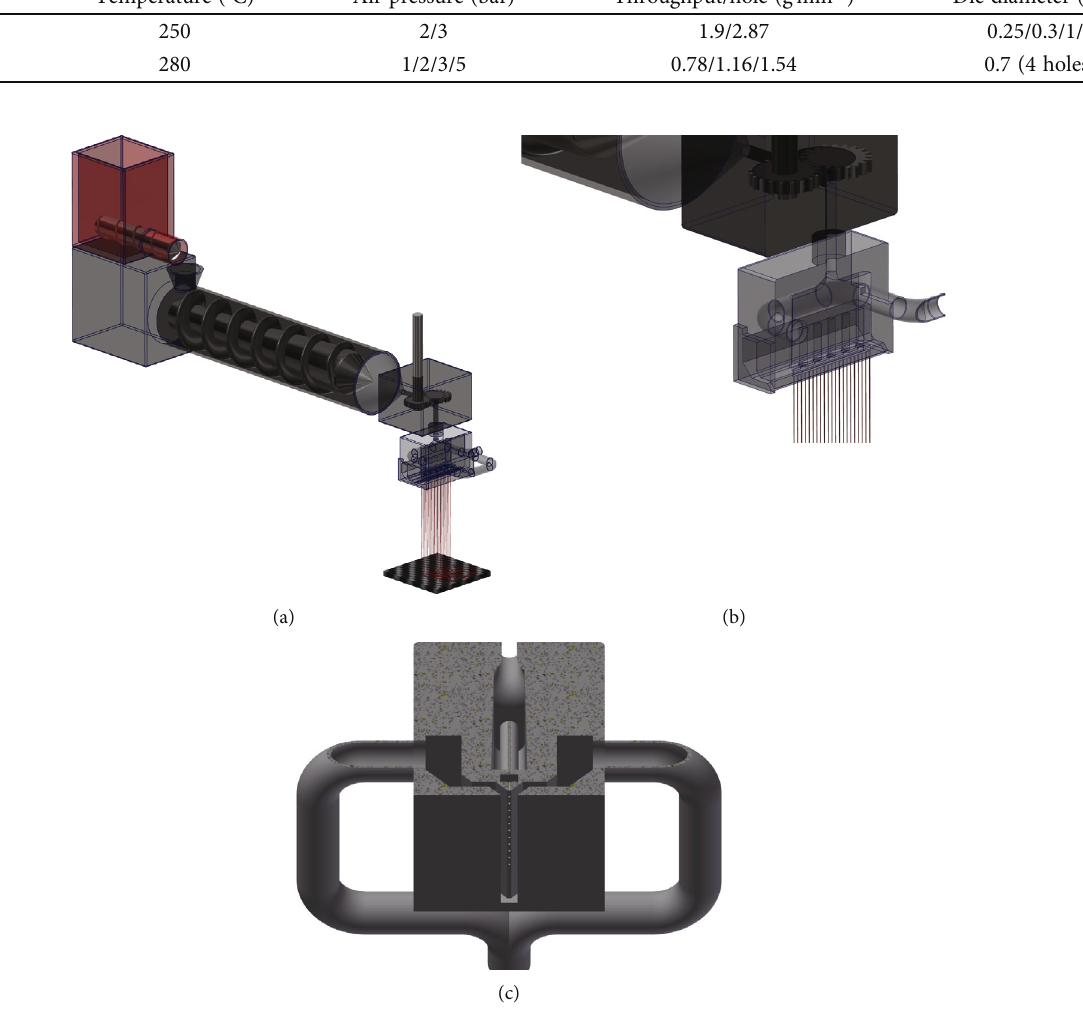
Figure 4: Schematic fi gure of pilot melt blowing device with hot air stretching and fi bre laydown (a), half-view of expansion into spinneret setup with metallic melt fi lter candles, distribution plate, spin head featuring twenty-one holes and exiting fi bres (b), and spinneret with fi lters as well as die hole and air blade con fi guration (c). Table 3: Process parameters used on the melt blowing device for HL712FB.